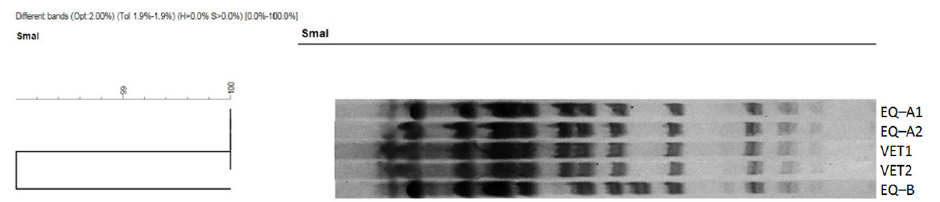
Figure 2. The PFGE dendogram of the mecC -MRSA isolates. All isolates, except EQ-B, clustered together and had the same banding pattern. For the original gel picture, please see Figure S1.